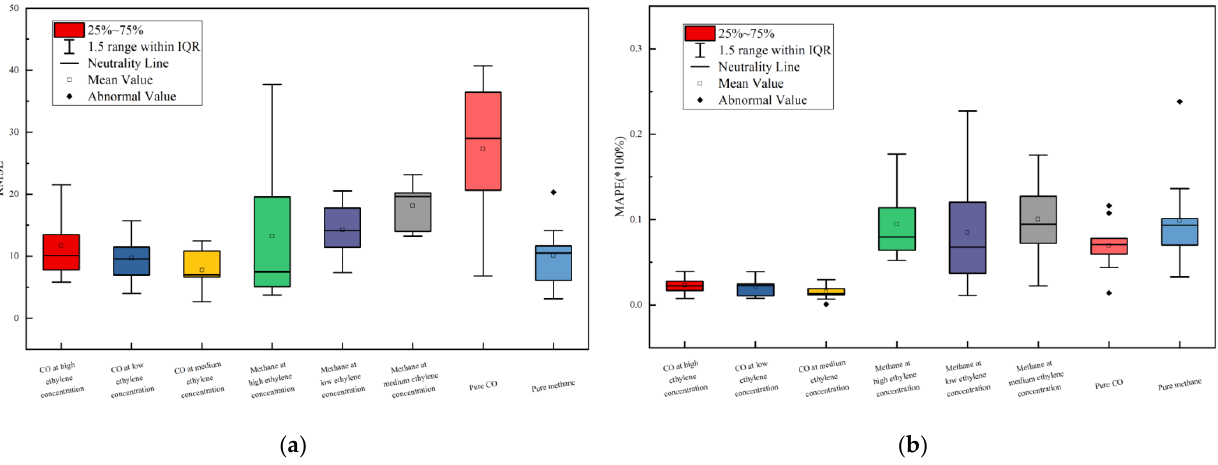
Figure 13. Box plots of carbon monoxide and methane concentration prediction errors under the condition of ethylene as the background gas. ( a ) RMSE; ( b ) MAPE. prediction effect of the PSO-LSSVM model on turbulent gas mixtures. In order to further illustrate the composition prediction performance of the PSO-LSSVM model for turbulent mixed gas, this paper uses the SVM and LSSVM methods to predict the ethylene concen- tration in the mixed gas under the same conditions. The comparative experimental results are shown in Table 12. Table 10. Concentration prediction results for carbon monoxide and methane with ethylene as the background gas.